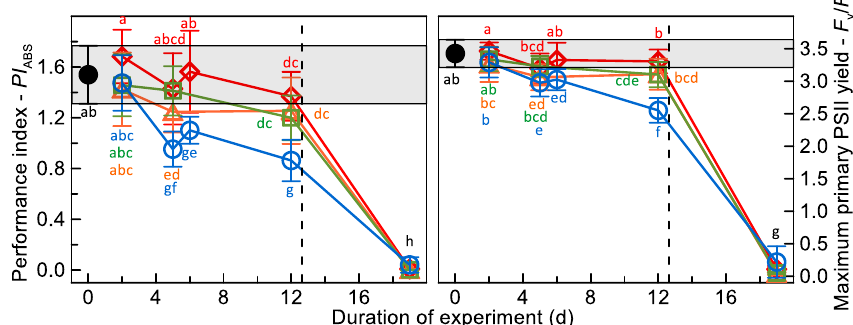
Figure 3. Means (±SD, n = 6) of the performance index ( PI ABS ) and the maximum primary yield of PSII ( F v / F o ) of banana fruit obtained from the polyphasic rise of the rapid chlorophyll-fluorescence induction curve measured with the OJIP test (FluorPen) during cold storage ( circles: 5 °C; squares: 10 ° C; Δ trian gles: 11.5 °C; diamonds: 13 °C) and shelf life. The vertical dashed line indicates the end of cold storage on day 12 of the experiment. The filled circles reflect the means (the grey horizontal bar shows the respective SD) of all bananas ( n = 76), measured before storage. Different small letters indicate significant ( p < 0.05) differences between means.